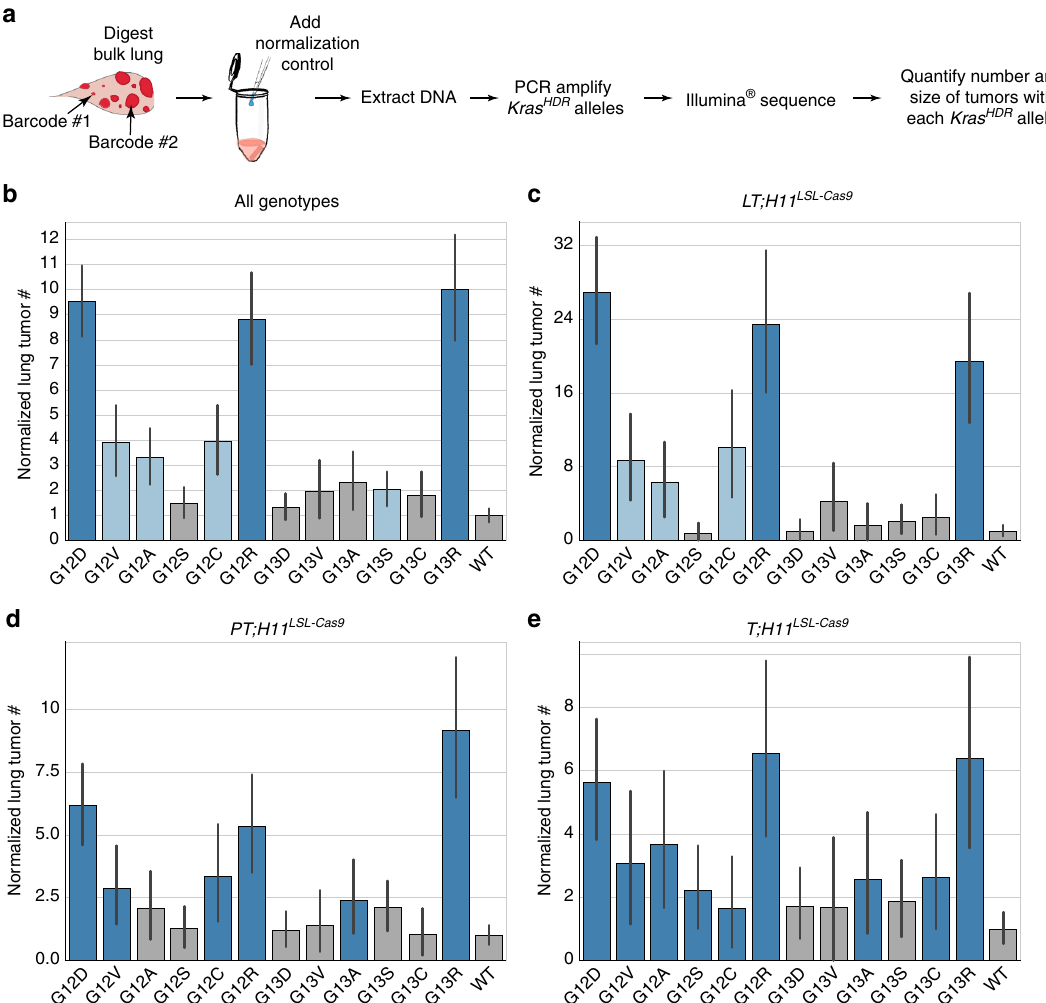
Fig. 6 Multiplexed, quantitative analysis of Kras mutant oncogenicity using AAV/Cas9-mediated somatic HDR and high-throughput sequencing of barcoded lung tumors. a Pipeline to quantitatively determine the number, size, and genotype of individual tumors directly from bulk lung samples by high- throughput sequencing of tumor barcodes. b – e Number of lung tumors harboring each mutant Kras allele normalized to its initial representation (mutant representation in the AAV plasmid library divided by WT representation in the AAV plasmid library) and relative to WT (mutant tumor # divided by WT tumor #). Variants present in signi fi cantly more tumors than WT (two-sided Fisher ’ s exact test; p < 0.05) are colored blue; darker blue indicates no signi fi cant difference from G12D ( p > 0.05), lighter blue indicates signi fi cantly less tumors with the indicated variant than G12D ( p < 0.05). Error bars are bootstrapped 95% con fi dence intervals. Bar plots were generated from pooled data from all mouse genotypes ( N = 15) ( b ), or individually from LT;H11 LSL-Cas9 ( N = 6) ( c ), PT;H11 LSL-Cas9 ( N = 6) ( d ), or T;H11 LSL-Cas9 ( N = 3) ( e ) mice. Note that different y axis scales are used in each